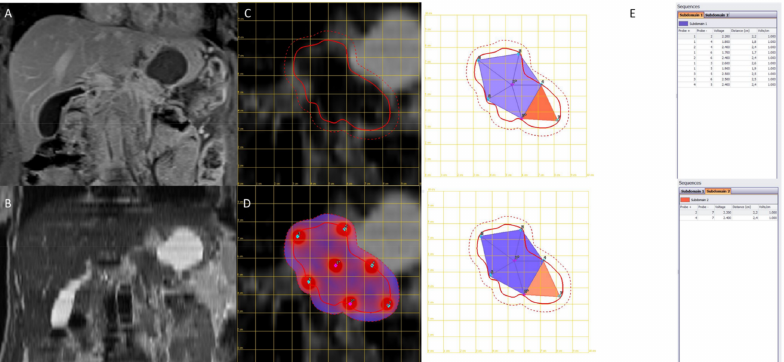
Figure 2. The panel reports an example of preoperative planning performed with the software Pulsar. In ( A ) (VIBE T1- weighted image post-contrast medium in coronal plane) and ( B ) (HASTE T2-weighted image in coronal plane) there are the magnetic resonance (MR) sequences used to identify the target areas, ( C ) represents the definition of the lesion contours, ( D ) represents the results of the planning in terms of number and position of the electrodes and ( E ) shows defined electrochemotherapy (ECT) treatment parameters for each subdomain (the treatment was divided into two subdomains, considering that the proposed optimized electrode number to obtain complete coverage of the lesion was